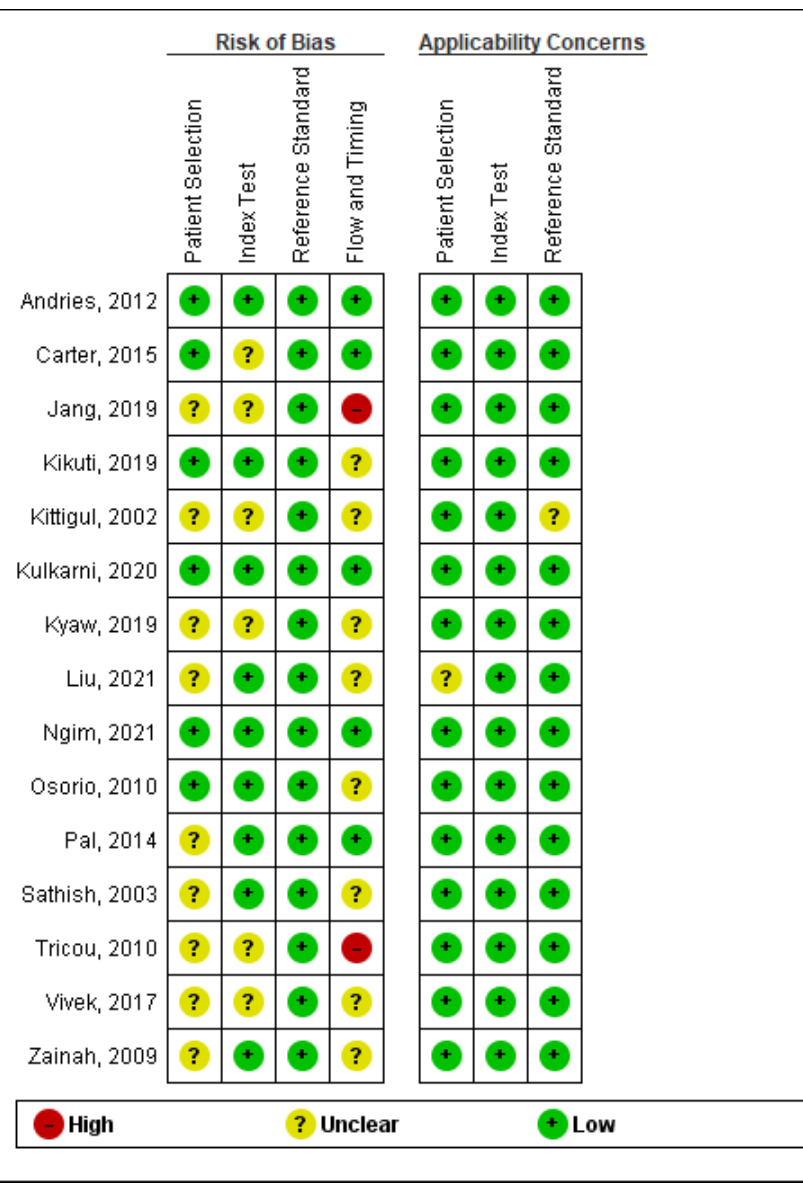
Figure 2. Risk of bias and applicability concerns summary: authors’ (ZS and AS) judgments about each domain for each included study